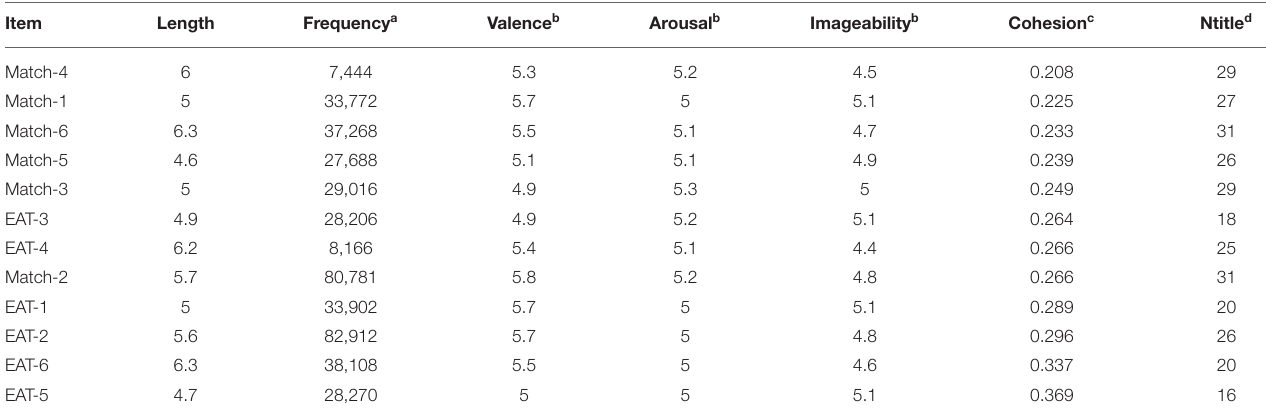
TABLE 1 | Supra-lexical word length, word frequencies, psycholinguistic rating values as well as semantic cohesion and number of different titles obtained for EAT-derived (EAT-1 to EAT-6) and matched (Match-1 to Match-6) items. Item Length Frequency a Valence b Arousal